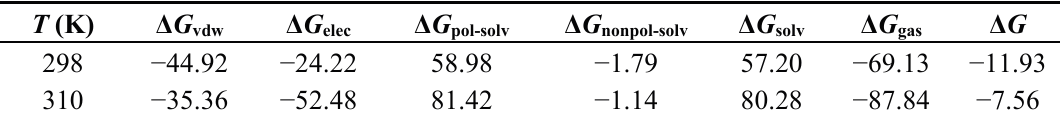
Table 4. Energy terms of MM-PBSA results for GA-LYS system at two different temperatures ( k